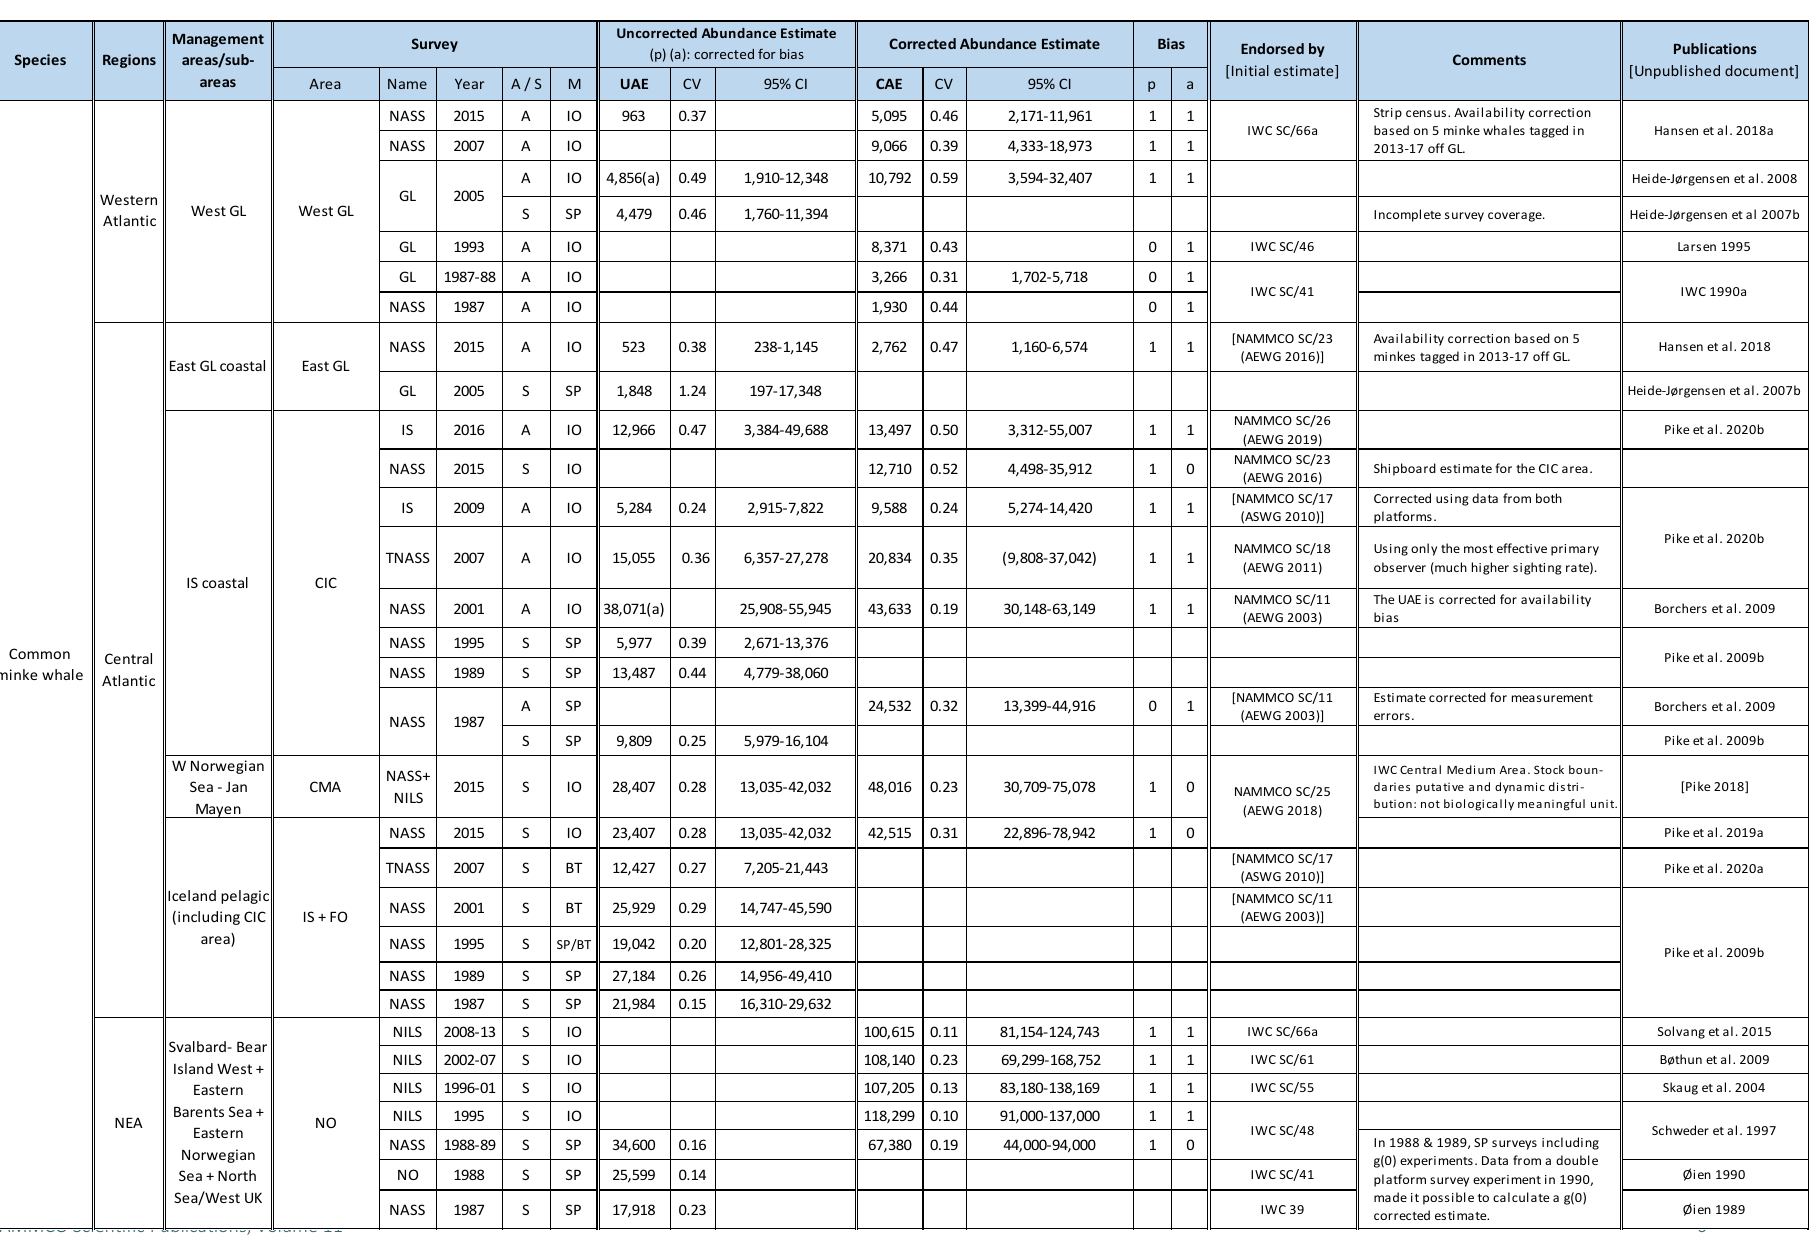
IWC Central Medium Area. Stock boun- daries putative and dynamic distri- bution: not biologically meaningful